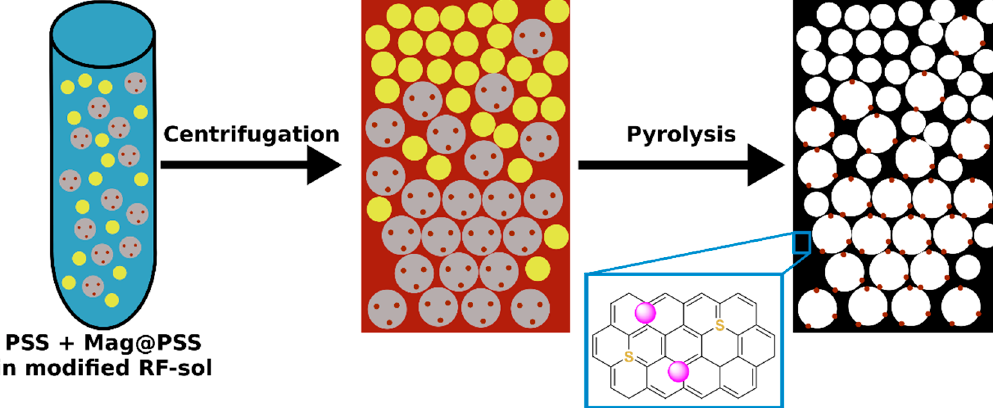
Scheme 1. Synthetic pathway for synthesizing gradient porous modified carbon aerogels with magnetic gradients. Yellow dots: poly(styrene ‐ co ‐ styrene sulfonate) (PSS) nanoparticles; brown dots: magnetite nanoparticles; gray/brown dots: